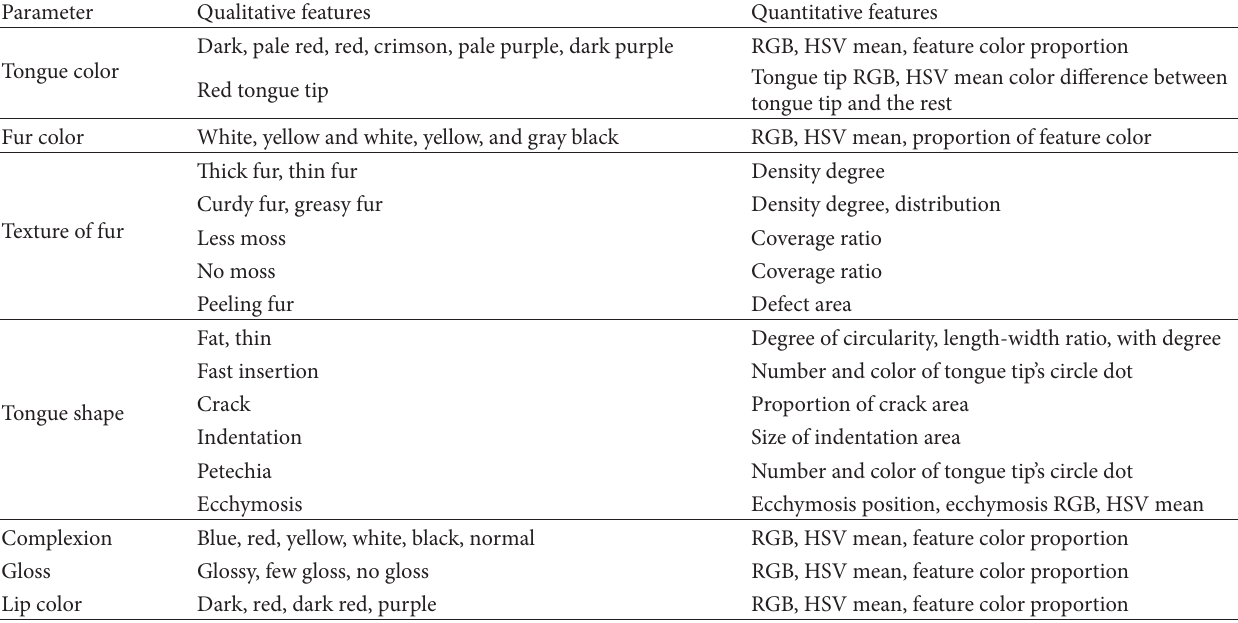
Table 1: Qualitative and quantitative features of